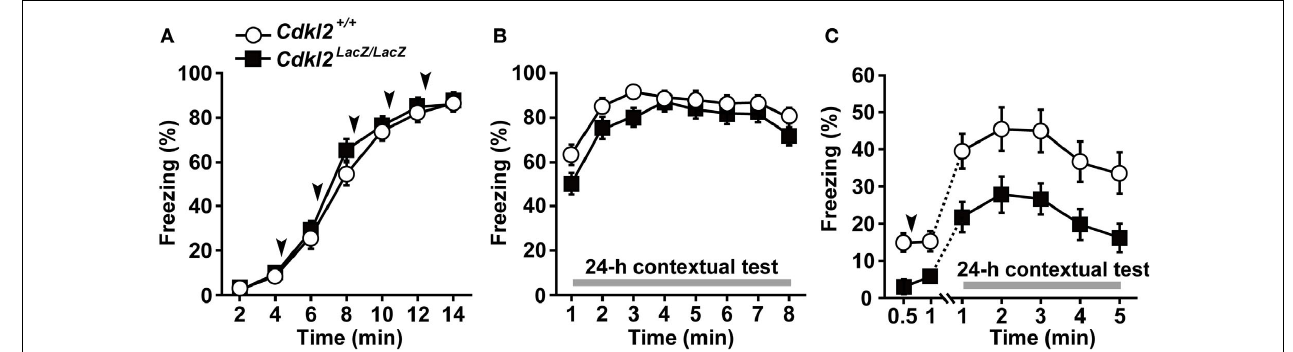
FIGURE 5 | Contextual fear conditioning. Freezing responses were evaluated in two different protocols, (I) and (II). (A) In protocol (I), fi ve footshocks (0.7 mA for 1 s, 2 min apart) were given at 4, 6, 8, 10, and 12 min after the animals were placed in the chamber. Pre-shock baseline freezing (4 min) was not signifi cantly different between Cdkl2 + / + and Cdkl2 LacZ/LacZ mice. During conditioning, the percent time spent freezing was determined. Arrowheads indicate when the footshock was administered. (B) In the 24-h contextual test, percent time spent freezing was determined for 8 min. Repeated measures ANOVA revealed no signifi cant main effect of genotype on conditioning ( F = 0.034, P = 0.8559) or (1,28) in the 24-h contextual test ( F = 2.295, P = 0.1410), and there was no (1,28) signifi cant interaction between genotype and time of conditioning ( F = 1.626, P = 0.1727) or in the 24-h contextual test ( F = 1.210, (4,112) (7,196)